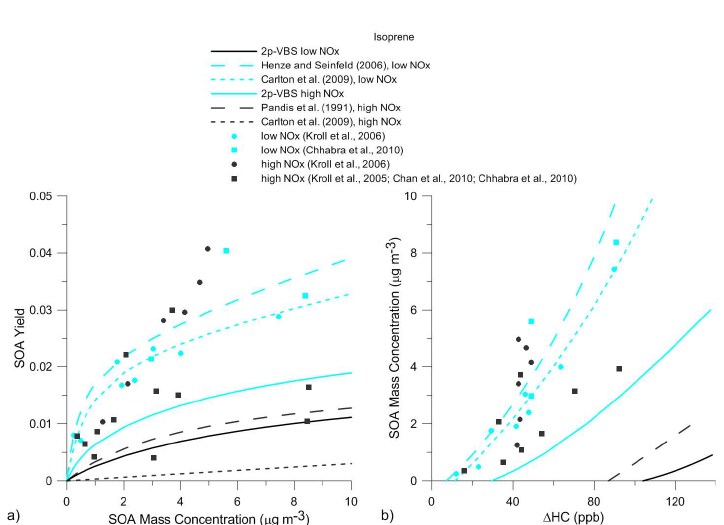
Fig. 2. Evaluation of 2p and 2p-VBS parameterizations for isoprene under low-NO x (cyan) and high-NO x (black) conditions. (a) Theo- retical yield curve (SOA yield vs. SOA mass concentration); (b) predicted SOA mass curve (SOA mass concentration vs. level of reacted hydrocarbon, 1